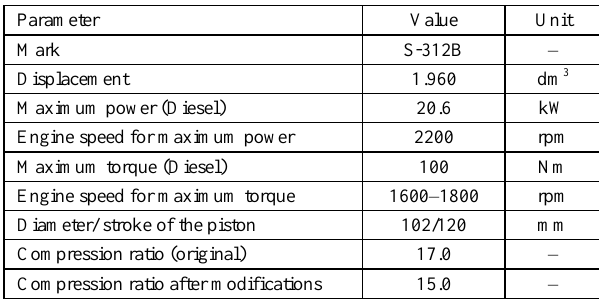
Table 4. Basic construction parameters of the engine